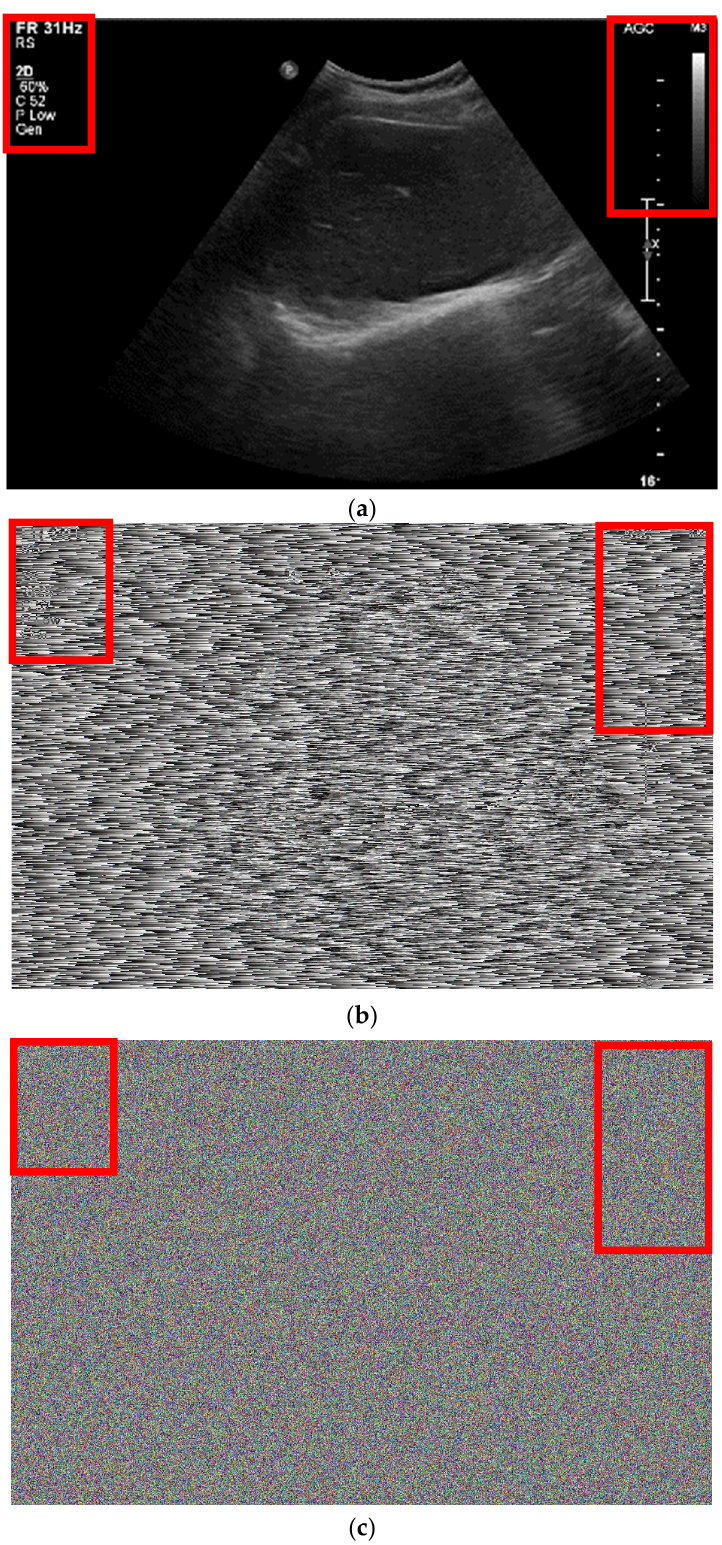
Figure 12. ( a ) Obtained original ultrasound image and enlarged images of ( b ) Figure 4i and ( c ) Figure 10i.